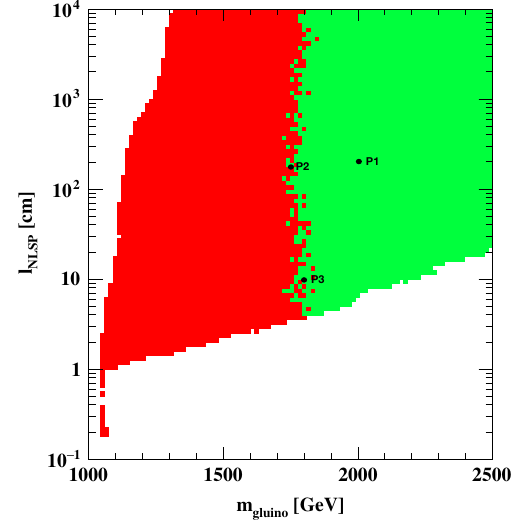
Fig. 3 Exclusion limits in the U model obtained with CheckMATE2 . Red (green) points are excluded (allowed) by direct SUSY searches at the LHC. Also shown are the benchmark points P1-P3 of Table 1